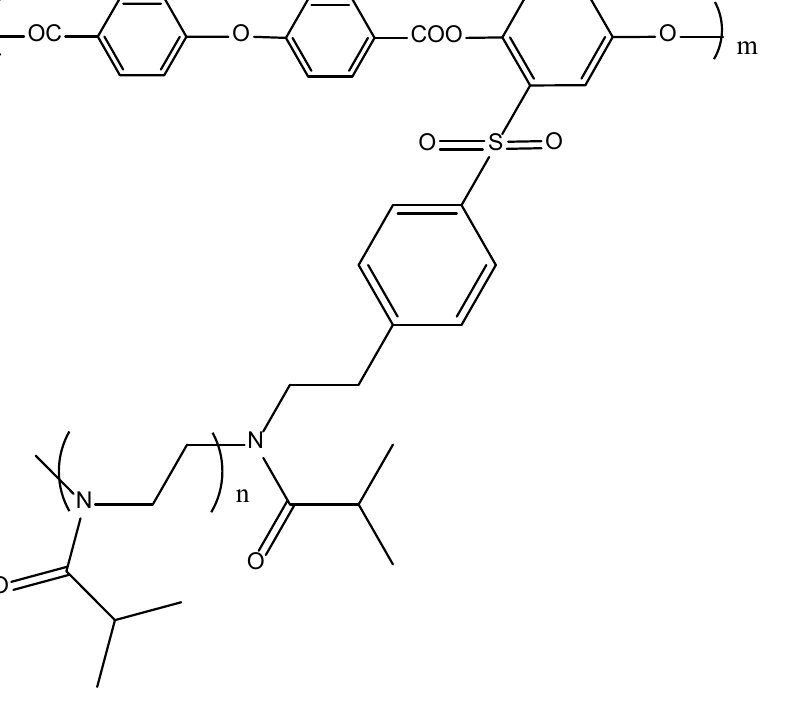
Figure 1. Chemical structure of APE O -g-PiPrOx.